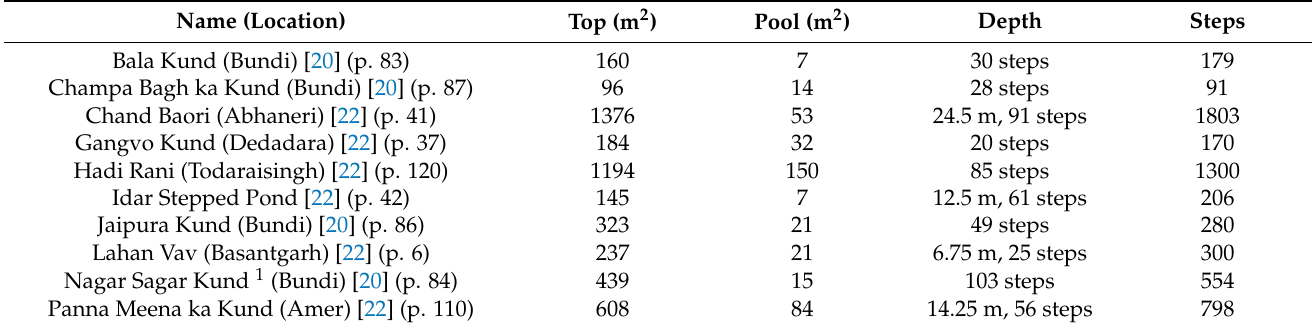
Table 1. Ten examples of stepped ponds that follow the form described, with architectural drawing sources cited. Some have alternative names, and in such cases, the name in the table is taken from a recent source, such as [23]. The top plan area is of the basic well opening, excluding surrounds. The number of steps only counts those in the main surfaces, quantified as the number of discrete horizontal walking surfaces.